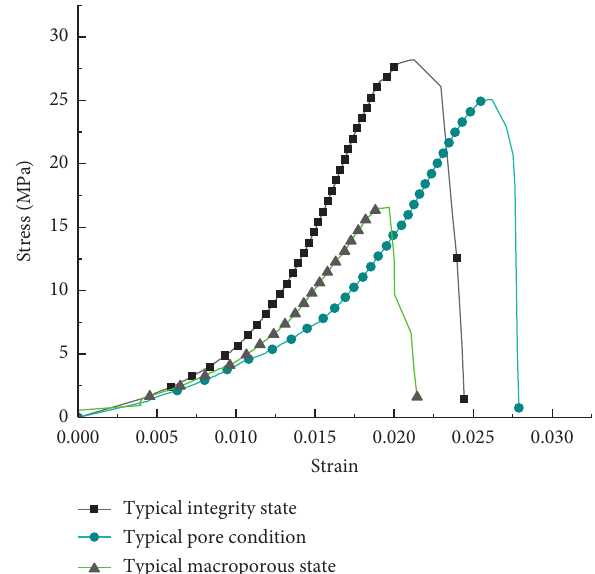
Figure 5: Stress-strain curves of rock samples with different pore